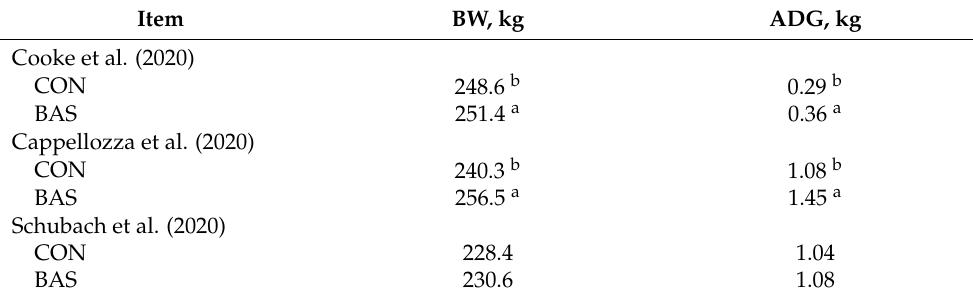
Table 1. Mean post-weaning performance of newly weaned calves receiving (BAS) or not (CON) a bovine appeasing substance at weaning 1,2